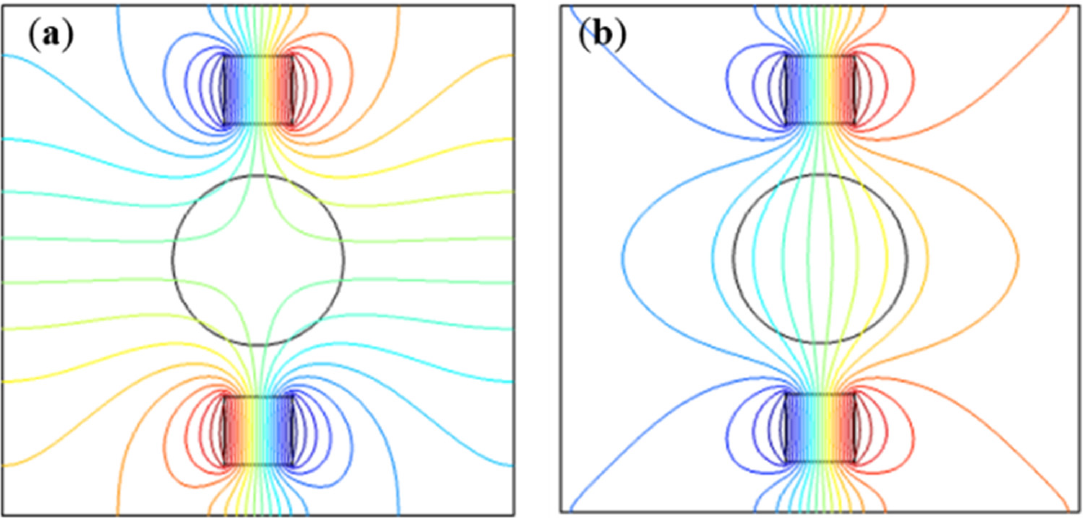
Figure 2. Qualitative representation of the fields generated by two permanent magnets ( a ) in attraction arrangement ( att ) and ( b ) in repulsion arrangement ( rep ).